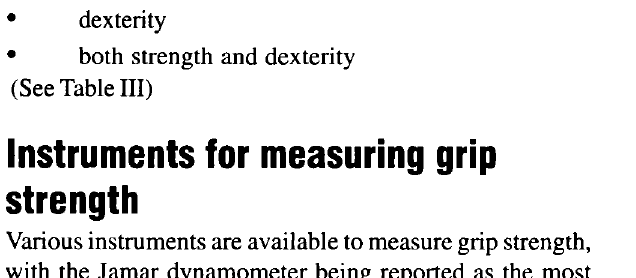
Table 2 List of tasks in the questionnaire